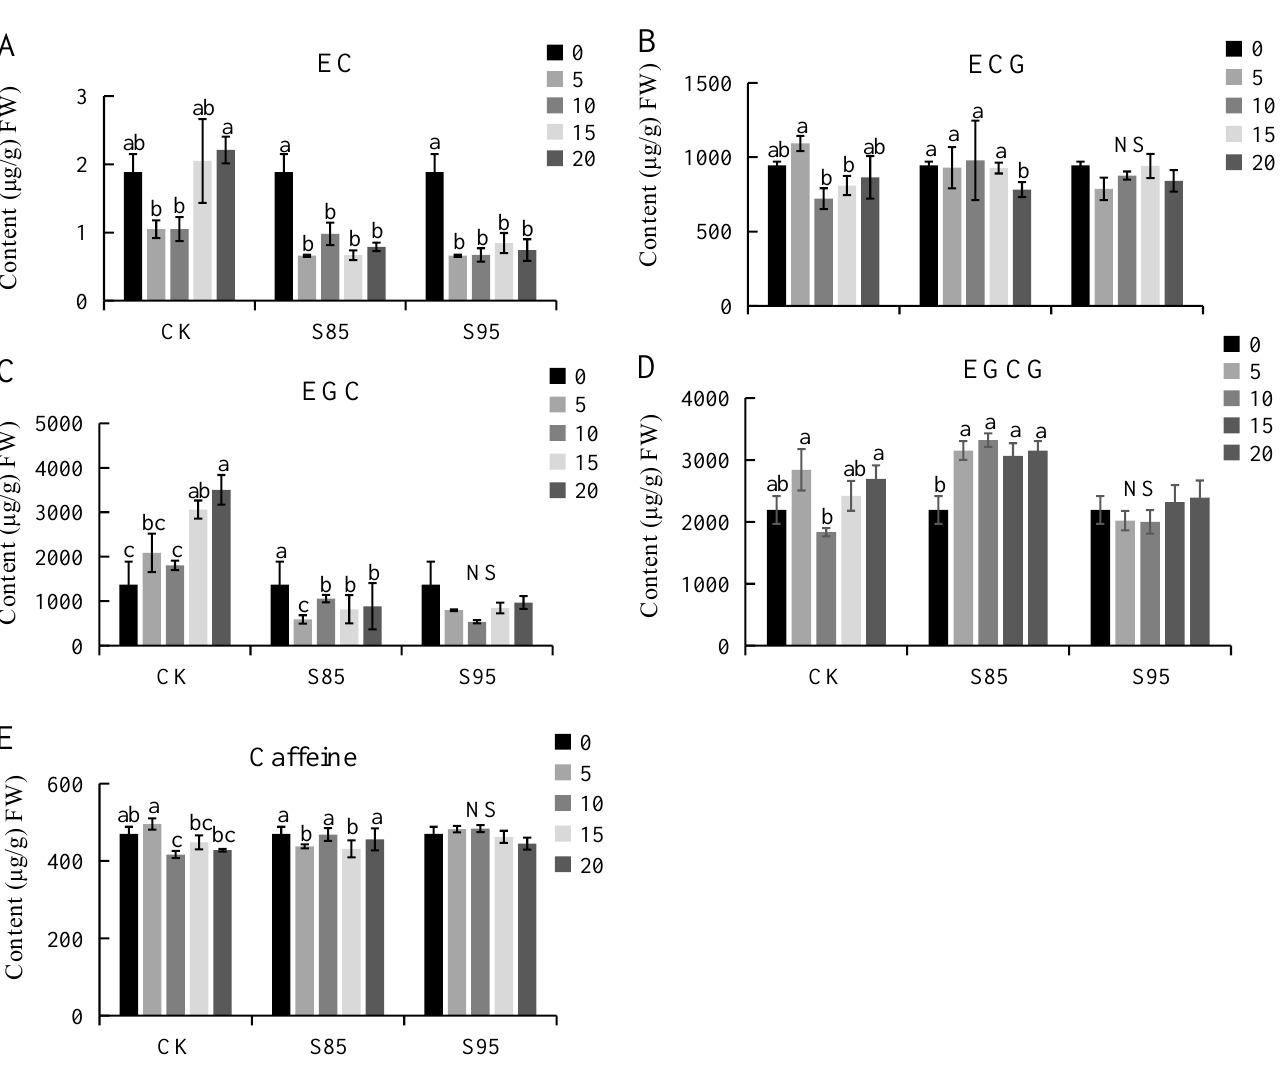
Figure 4. Effect of shading on the catechin and caffeine contents in tea leaves. ( A ) Epicatechin (EC); ( B ) Eepicatechin gallate (ECG); ( C ) Epigallocatechin (EGC); ( D ) Epigallocatechin gallate (EGCG); ( E ) Caffeine. CK is the control. ‘NS’ and different letters above the bar indicate significant ( p < 0.01; n = 3 biological replicates) differences between the control and shaded plants. Table 1. Overview of the RNA-seq